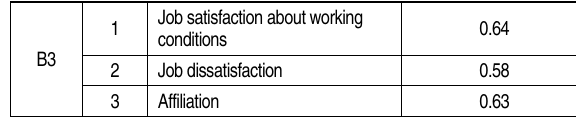
Table 3. Relationship between job insecurity